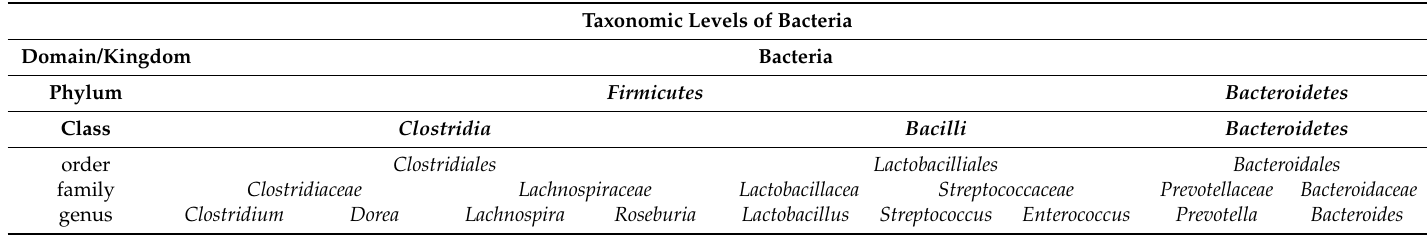
Figure 1. Impact of dietary fat (SFA versus PUFA) and fiber on gut microbiota and metabolic regulation. SFA is well known to induce metabolic dysregulation, while PUFA and fiber are well known to improve metabolic regulation. High intake of SFA will increase the cholesterol level in blood, which is an important risk factor for CVD. PUFA and fiber will decrease blood cholesterol and triglycerides, in addition to improve blood glucose regulation. The underlying mechanism of cardiometabolic disorders is inflammation. Both fiber and fat may change the gut microbiota composition. However, whether gut microbiota regulate inflammation directly by dietary interventions in humans is still to be elucidated. CVD: Cardiovascular diseases; PUFA: polyunsaturated fatty acids; SFA: saturated fatty acids. Table 1. Examples of taxonomic levels of human gut microbiota [4,11].